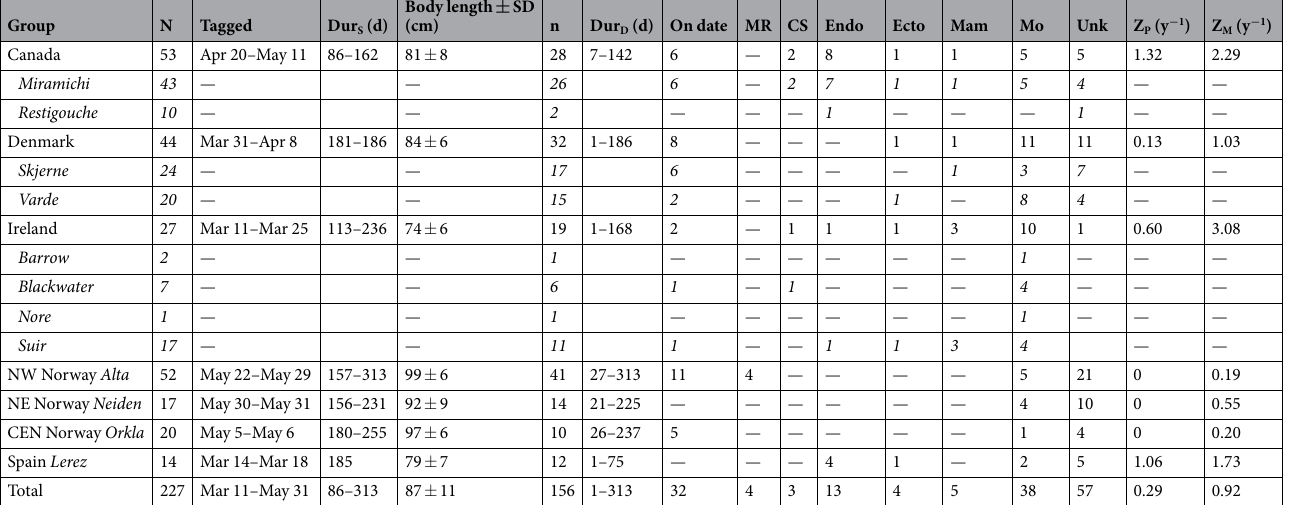
Table 1. Overview of tagged Atlantic salmon. The number of tagged fish (N), reporting tags (n), tags reporting at the pre-determined date (on date), tags retrieved from fish recaptured at sea (MR) or in the river as consecutive spawners (CS), and tags attached to fish experiencing undermined mortality (Mo), predation (Endo, Ecto, Mam) or unknown fate (Unk) are given. Dur S indicates the scheduled duration and Dur D indicates the deployment duration for the reporting tags. Z P and Z M denote the instantaneous predation and total mortality